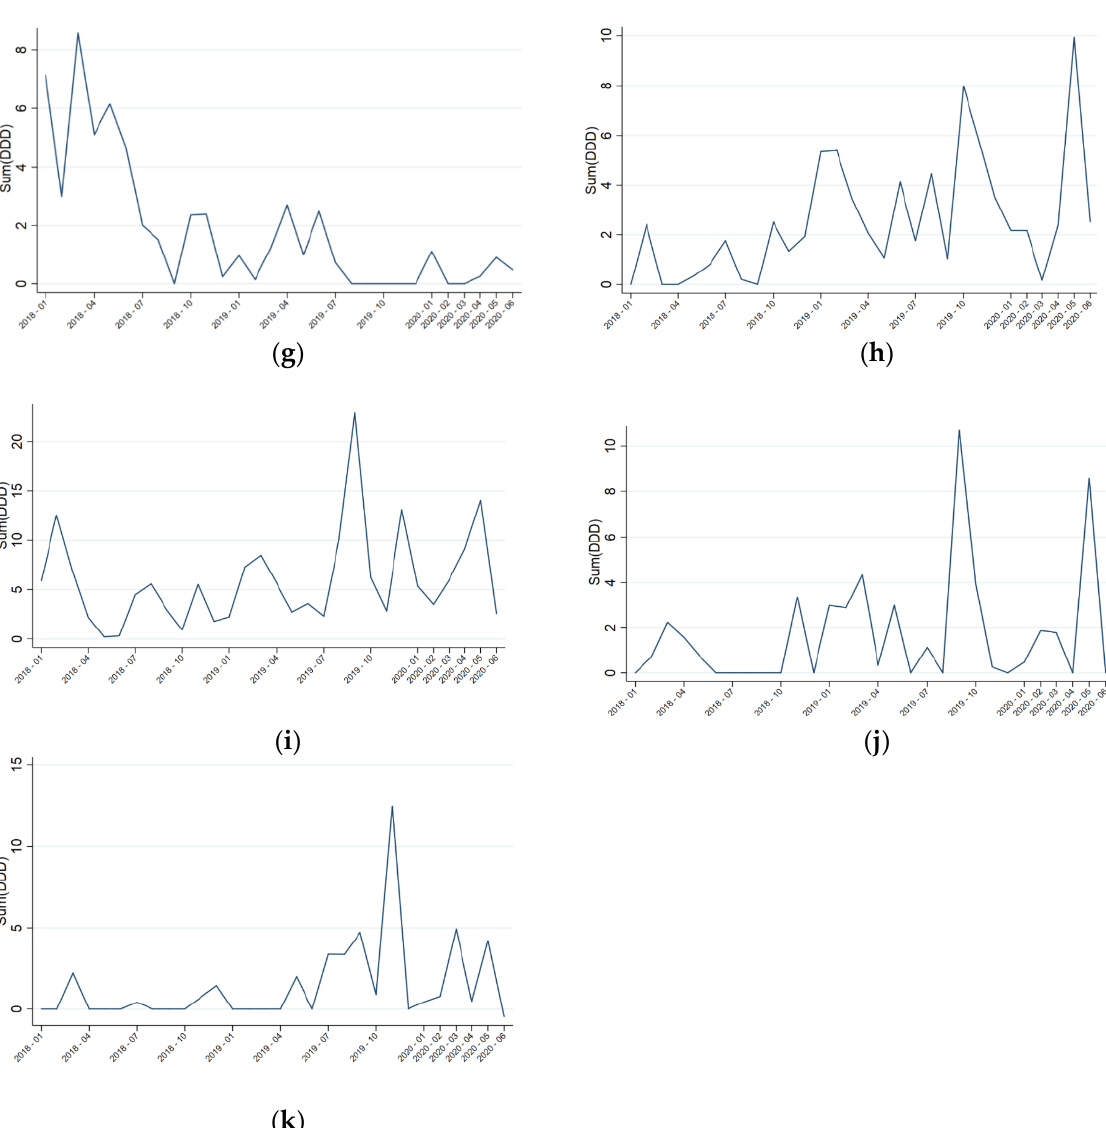
Figure 2. Evolution of drug consumption in the expanded-intensive care unit (ICU) expressed in defined daily doses (DDD)/100 bed-days. ( a ) Ceftriaxone: β-change 21.501, p = 0.029; ( b ) car- bapenems: β-change 26.103, p = 0.002; ( c ) daptomycin: β-change 18.093, p = 0.002; ( d ) azithromycin: β-change 19.422, p = 0.030; ( e ) linezolid: β-change 9.183, p = 0.011; ( f ) triazoles: β-change 7.939, p = 0.089; ( g ) vancomycin: β-change 1.816, P = 0.079; ( h ) novel cephalosporins/β-lactamase inhibitors: β-change –1.698, p = 0.225; ( i ) echinocandins: β-change –1.525, p = 0.626; ( j ) liposomal amphotericin B: β-change –0.311, p = 0.852; ( k ) ceftaroline: β-change –1.550, p = 0.339.